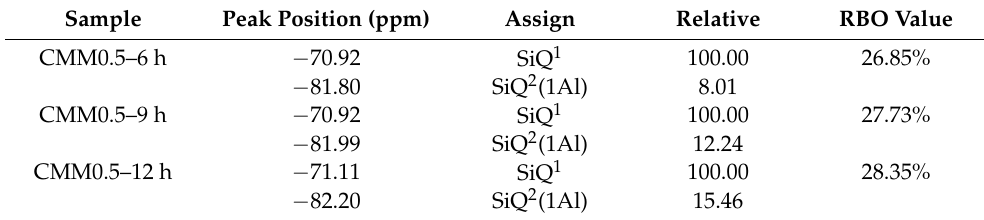
Figure 16. 29 Si NMR spectra of CMM0.5 autoclaved for ( d ) 6, ( e ) 9 and ( f ) 12 h. Table 6. The RBO values of CMM0.5 samples autoclaved for 6, 9 and 12 h.